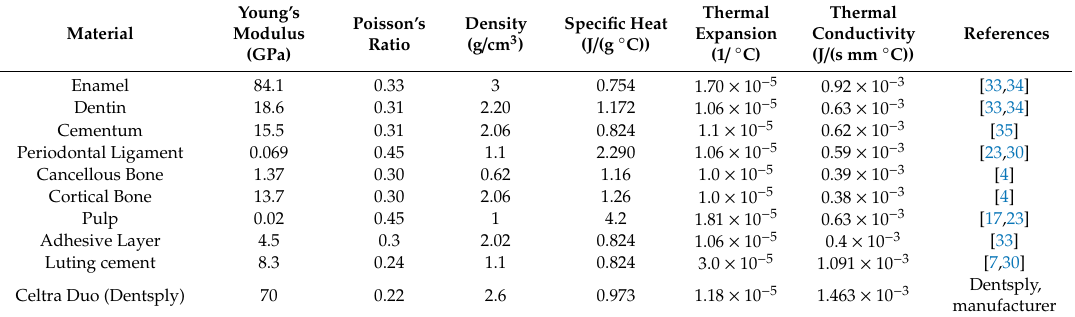
Table 1. Mechanical and thermal properties of each material and tooth structure.